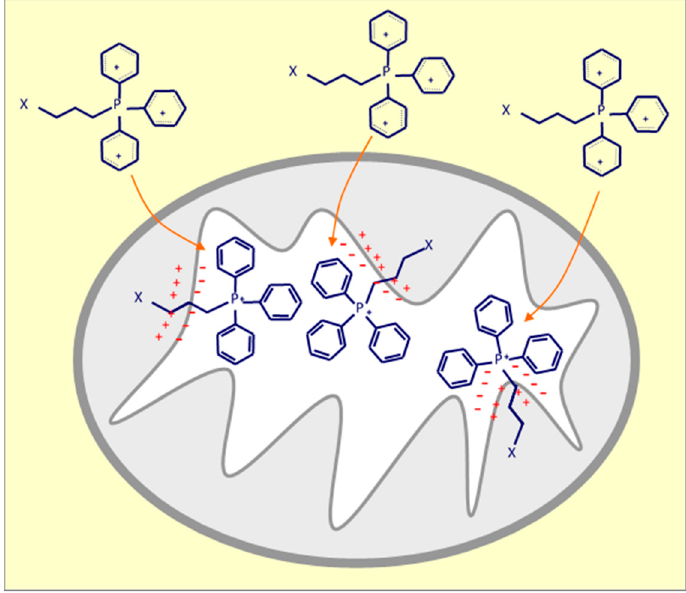
Figure 2. Positively charged triphenylphosphonium (TPP) anchors compound-X in the mitochondrial inner membrane (MIM) due to negative potential at the matrix face of the MIM.